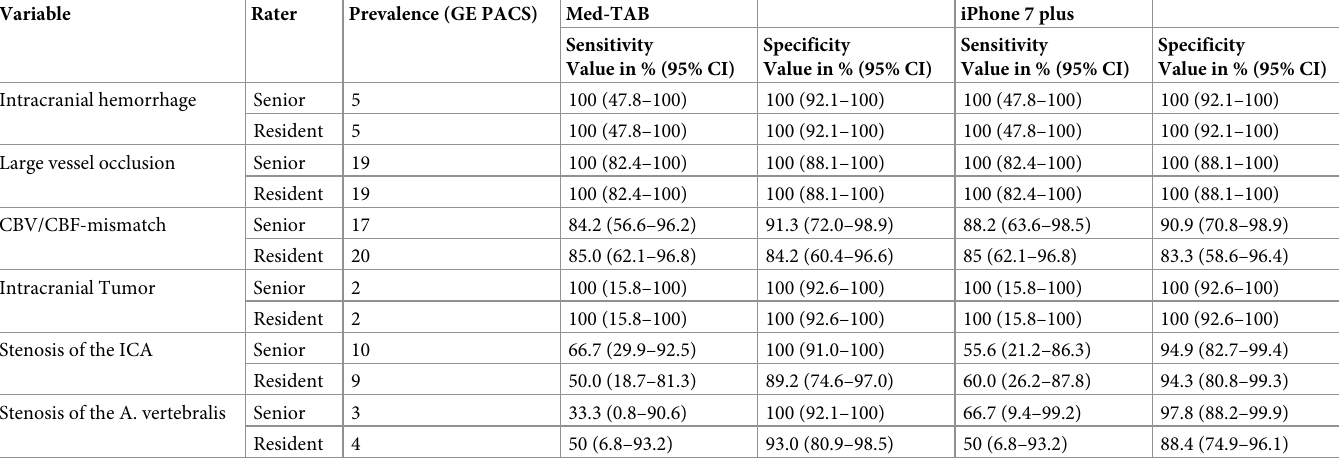
Table 1. Sensitivity and specificity for ICH, LVO, CBV/CBF-missmatch and Stenosis of the ICA/A. vertebralis.